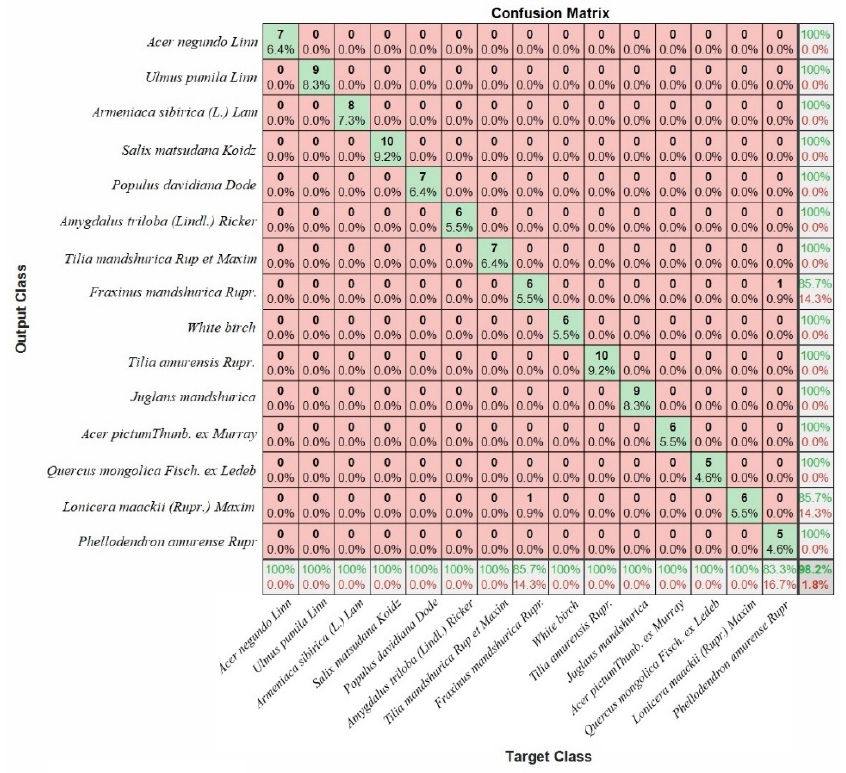
Figure 17. The confusion matrix of leaf small datasets by using ES-ResNet50.